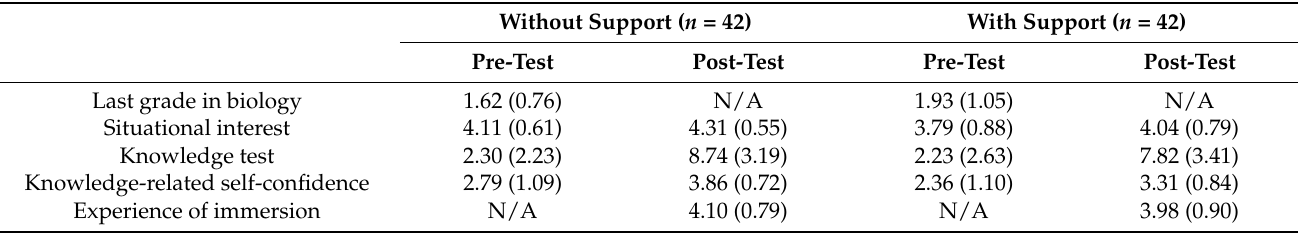
Table 1. Mean values (and standard deviations in brackets) of dependent variables.